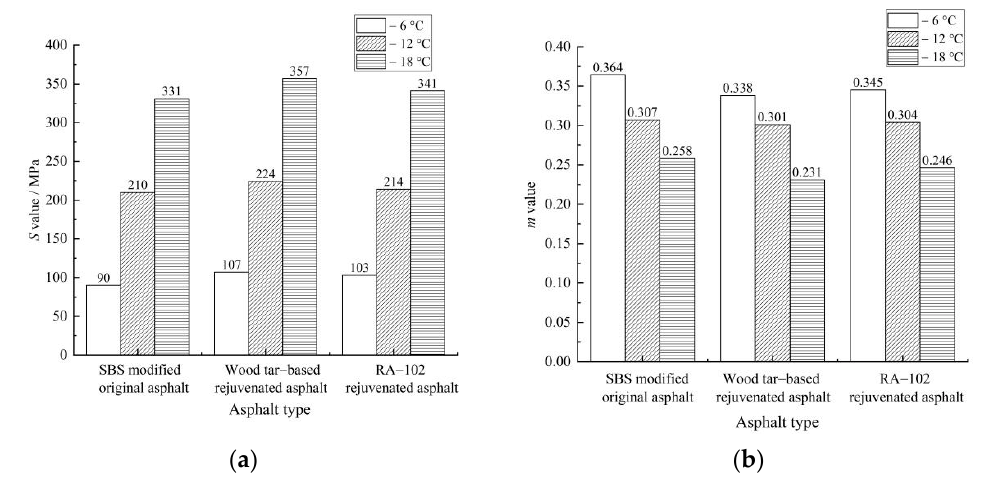
Figure 5. Test results of creep stiffness and creep rate of each asphalt binder: ( a ) S value and ( b ) m value.